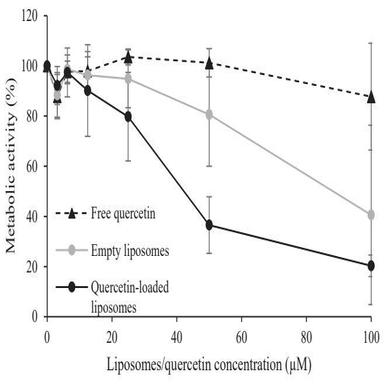
Quercetin-loaded liposomes affect cell metabolism in a colon cancer cells model. MTS assay on HCT-116 p53+/+ cells. Cells were treated with free quercetin (black dotted line), empty liposomes (gray line), or quercetin-loaded liposomes (black line) increasing concentrations for 48 h. In the graph, the percentage of metabolic activity relative to untreated cells (for empty liposomes and quercetin loaded liposome-treated cells) and to DMSO-treated cells (for free quercetin-treated cells), both arbitrarily set